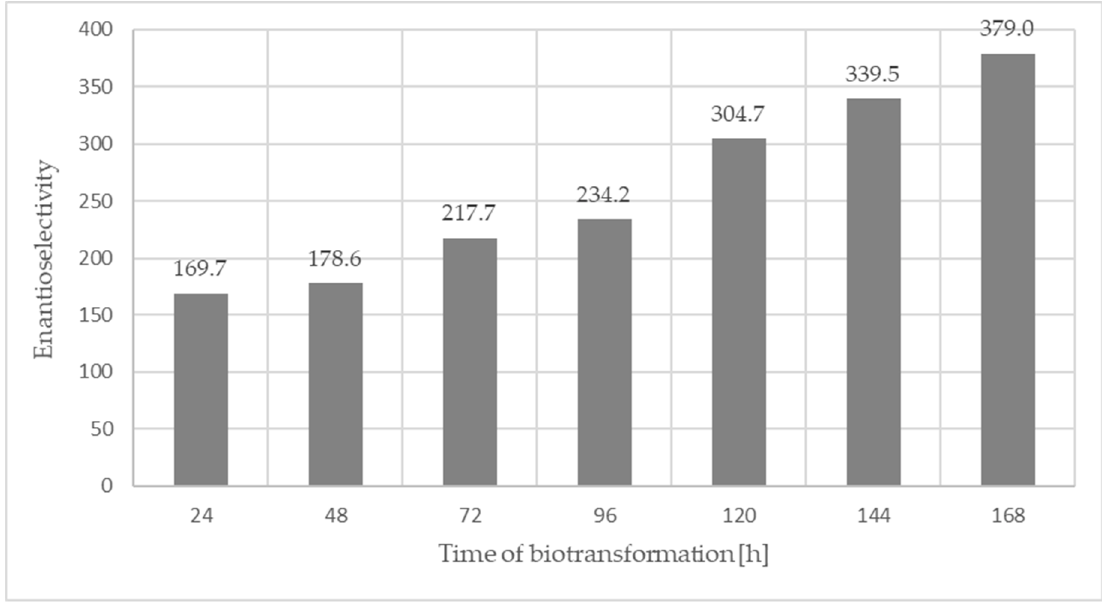
Figure 5. Effect of reaction time on the enantioselectivity (E) of the performed kinetic resolution of ( R , S )-phenylethanol in the two-phase catalytic system consisting of [EMIM][BF 4 ] and n-heptane as well as lipase from Burkholderia cepacia .